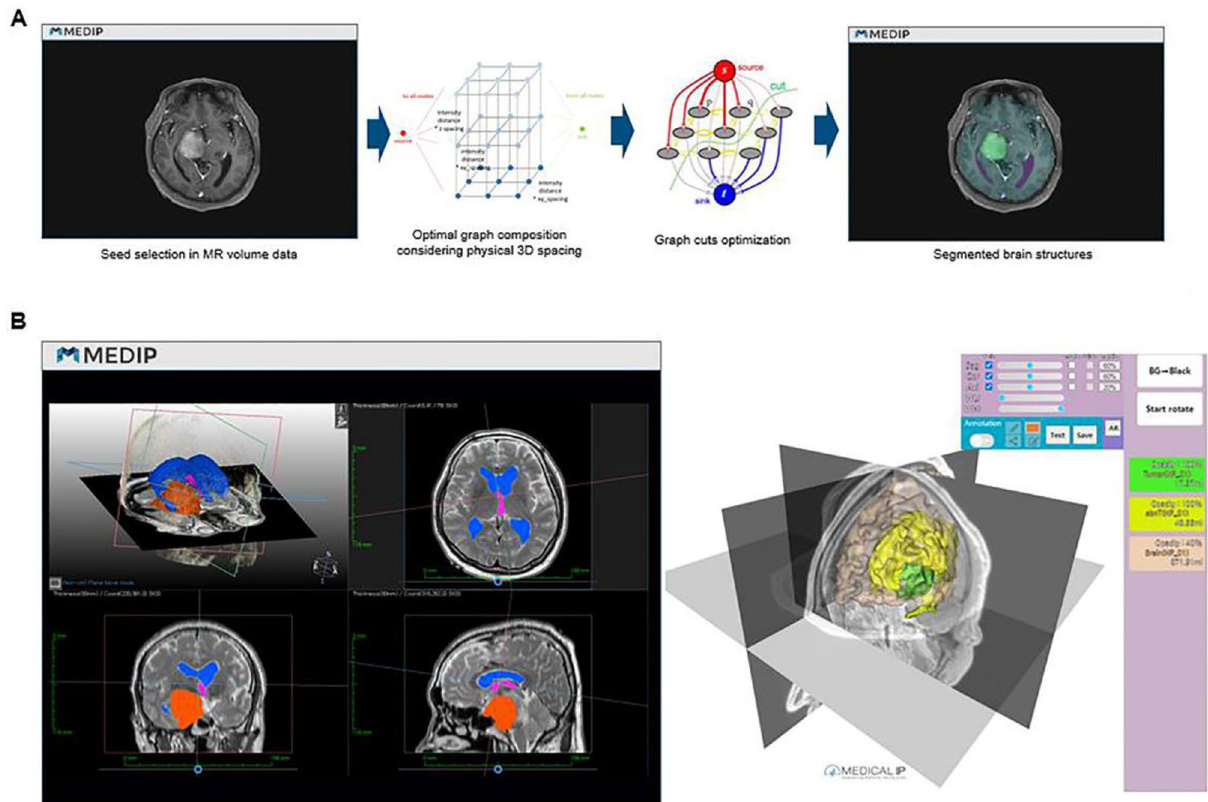
Figure 1. ( A ) Graph-cut algorithm. ( B ) Multiplanar reconstruction (MPR) function of MEDIP during the segmentation process. The finished result can be seen at the following link (http:// medic alip. synol ogy. me: 8082/ 191011_ NP01.